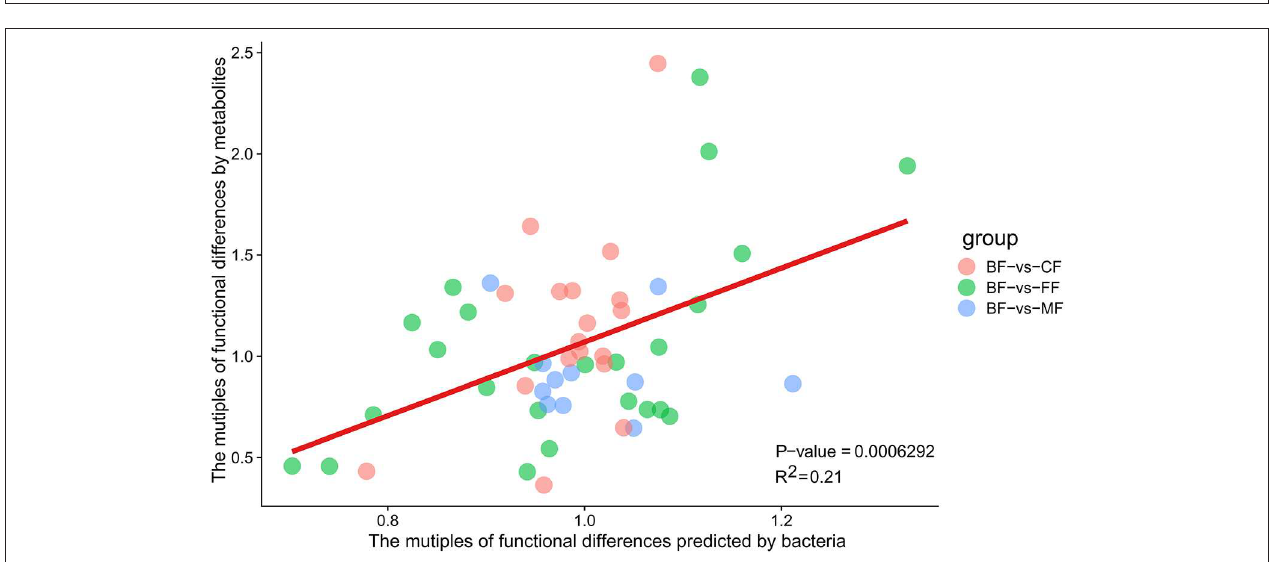
FIGURE 9 | The liner regression diagram of predicted functional differences multiples by bacteria and functional differences multiples of metabolites.